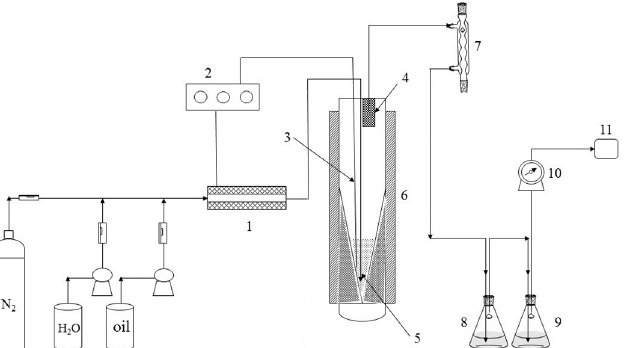
Figure 1. Schematic diagram of the FFB facility. 1, Preheating unit; 2, temperature displaying instrument; 3, electric couple thermometer; 4, filter unit; 5, catalyst; 6, fluidifying unit; 7, condensation unit; 8, ice-water bath; 9, alcohol bath; 10, wet-type gas flowmeter; 11, gas collection.